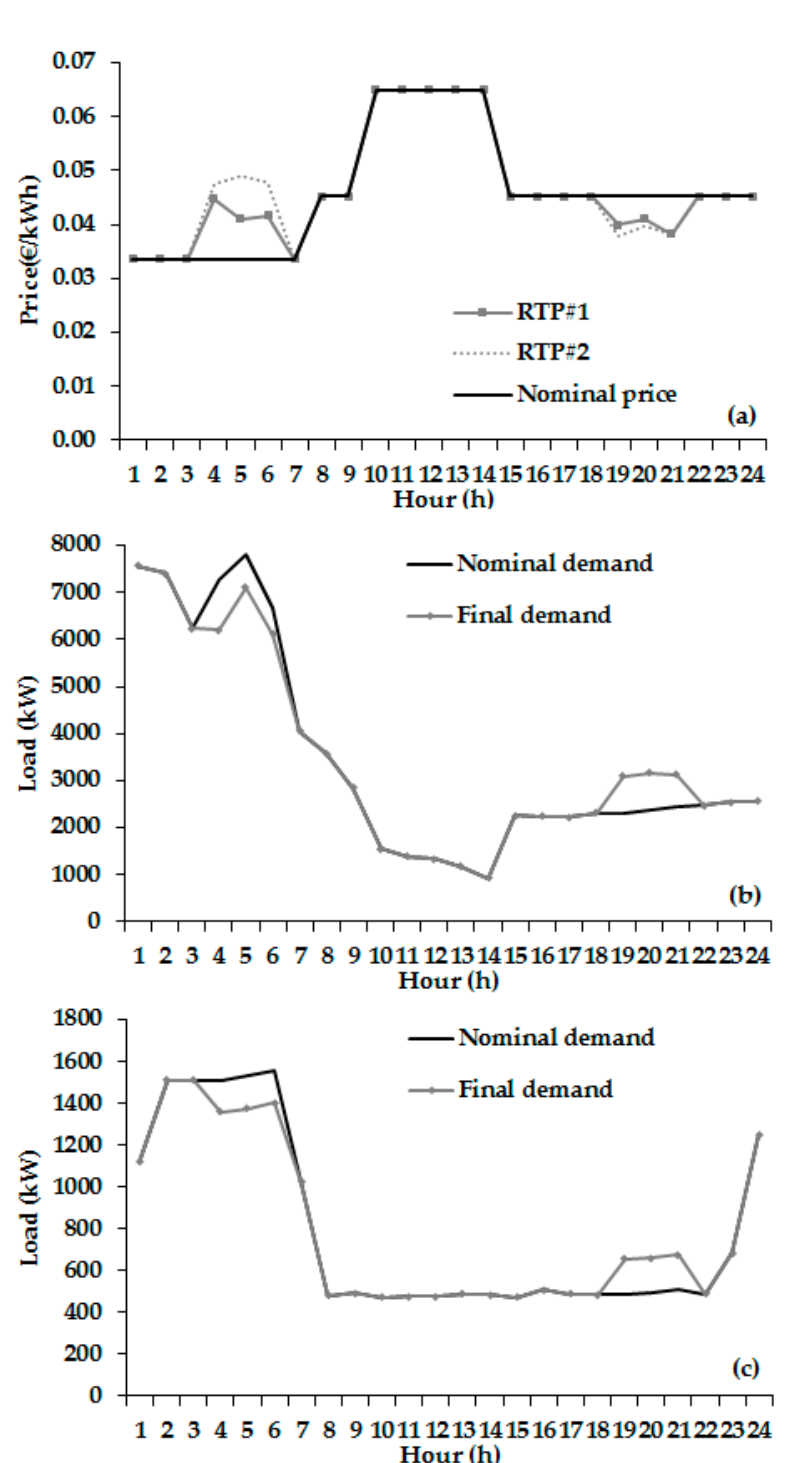
Figure 17. LS objective results with logarithmic DR model: ( a ) Nominal price and RTP; ( b ) nominal and final demand of consumer 1 and ( c ) nominal and final demand of consumer 2.